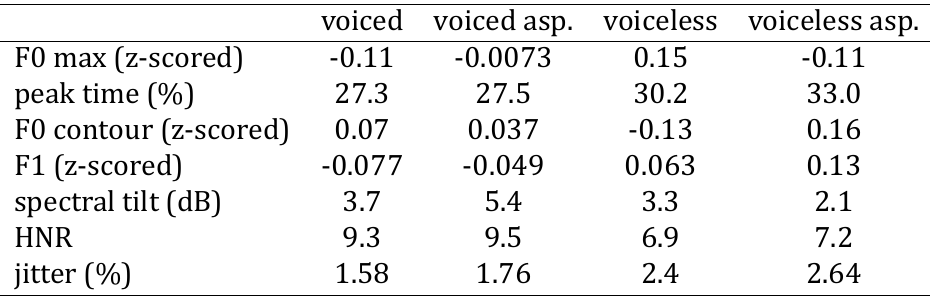
Table 11: Hindi acoustic measures by following stop